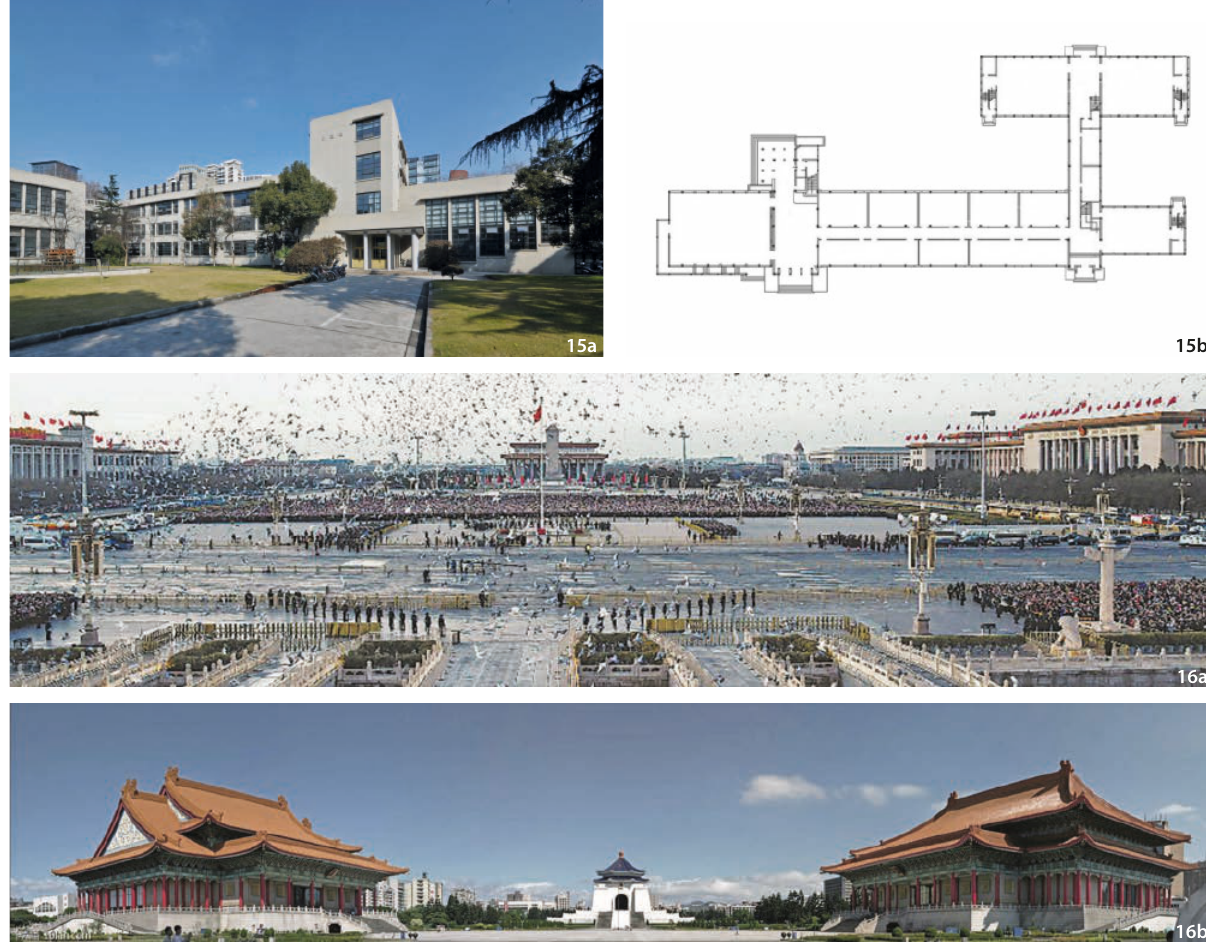
Figure 15a Wenyuan Building at Tongji University (Source: Zhong Tang). Figure 15b The ground floor plan of Wenyuan Building (Source: Feng Qian). Figure 16a Tiananment Square in Beijing (Source: http://k.sina.com.cn/article_6775659473_193dc5bd100100lz1p.html?from=travel) Figure 16b The square in front of the National Theatre and Concert Hall in Taipei (Source: